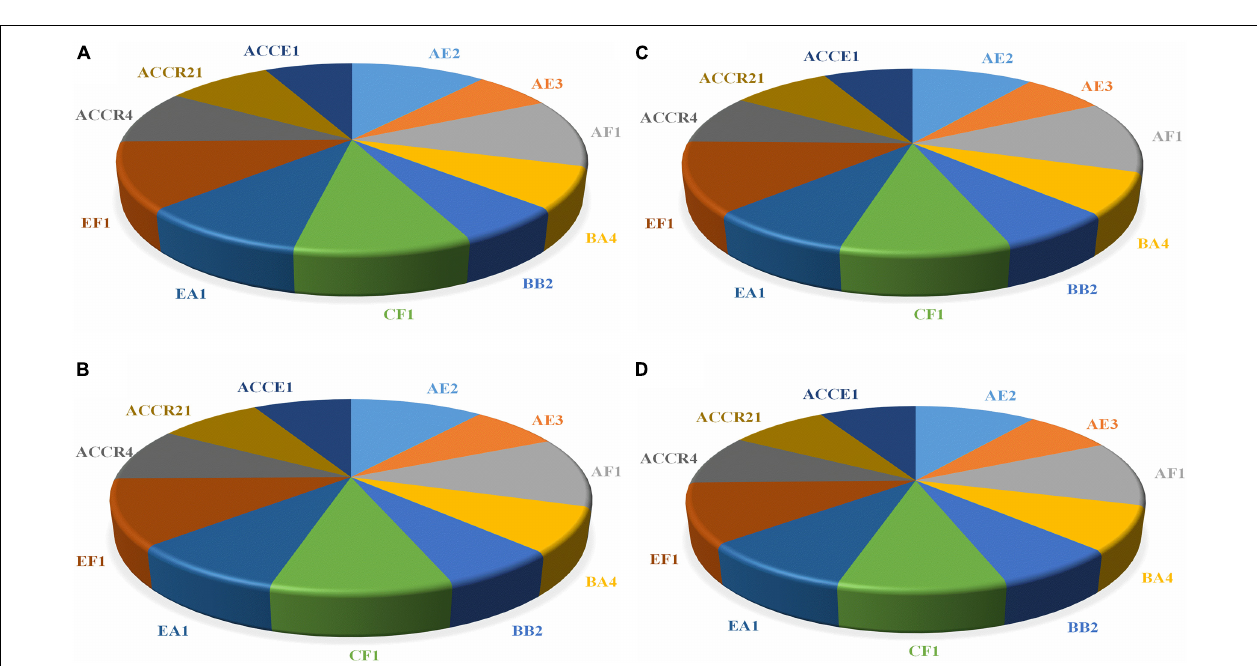
FIGURE 4 | The endophytic isolates displaying different concentrations of hydrolytic enzymes activity and proficient to degrade the cell wall of fungal pathogens. (A) Chitinase, (B) Protease, (C) Cellulase, and (D) Endoglucanase.